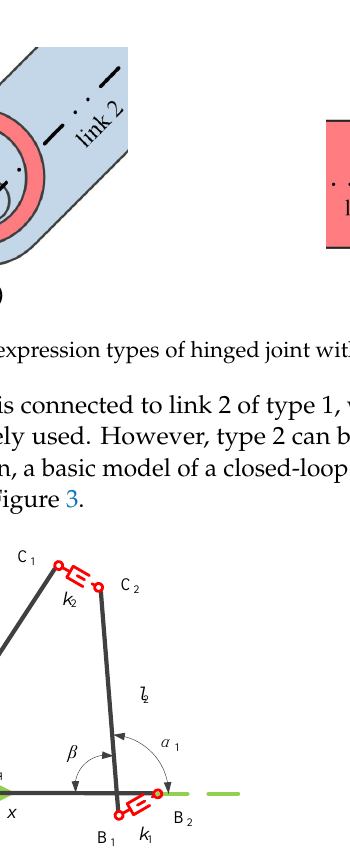
Figure 3. The closed-loop model with joint